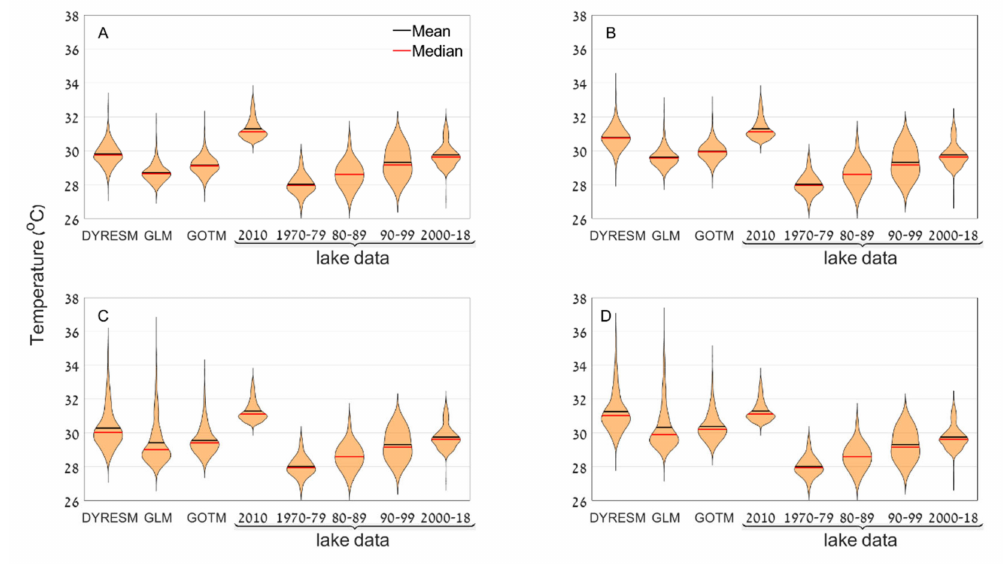
Figure 9. Violin plots of the simulated daily August temperatures down to a depth of 10m at 1 m increments for the last 5 years of the simulations for the Unchanged ( A ), LI ( B ), HW ( C ) and HW-LI ( D ) scenarios, and lake-based similar data for 2010 and for decadal temperatures